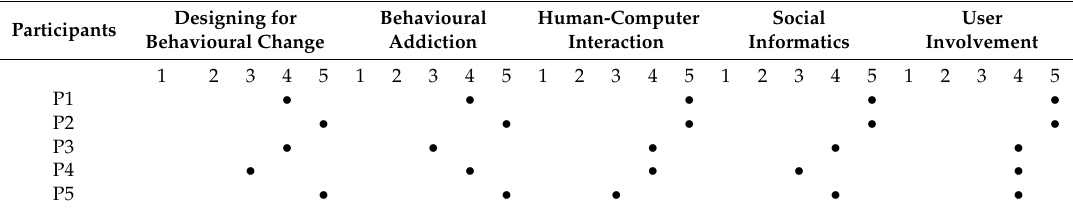
Table 2. The expert participants’ familiarity with relevant topics 1